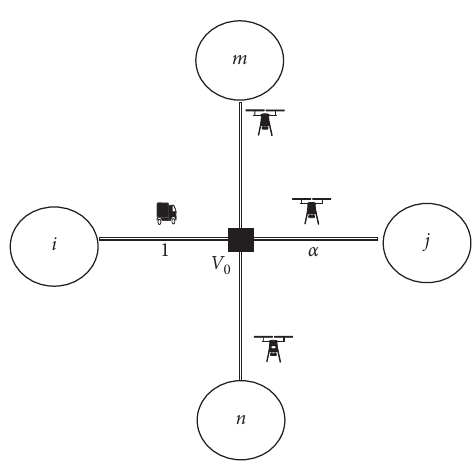
Figure 3: Practical best case truck-multiple drone delivery.